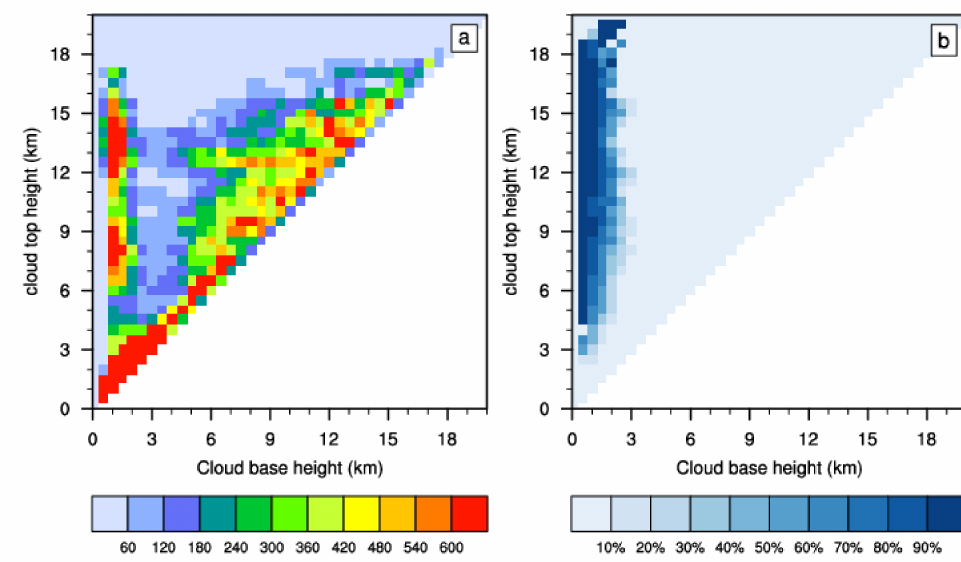
Figure 6. ( a ) Sample amounts and ( b ) probability of precipitation in two-dimensional space consisting of the cloud-top height and cloud-base height for single-layer clouds.